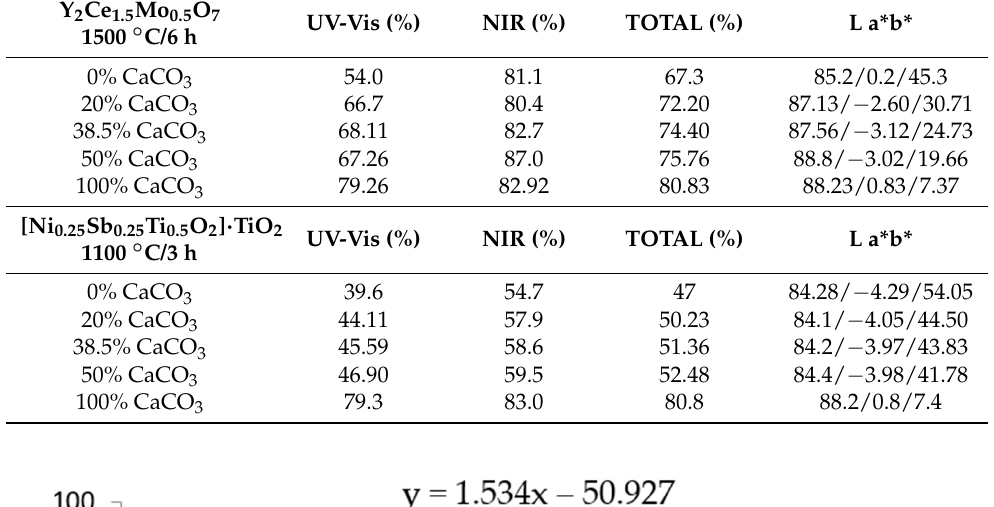
Table 4. Colorimetry and reflectance parameters for CaCO 3 addition to yellow pigments.